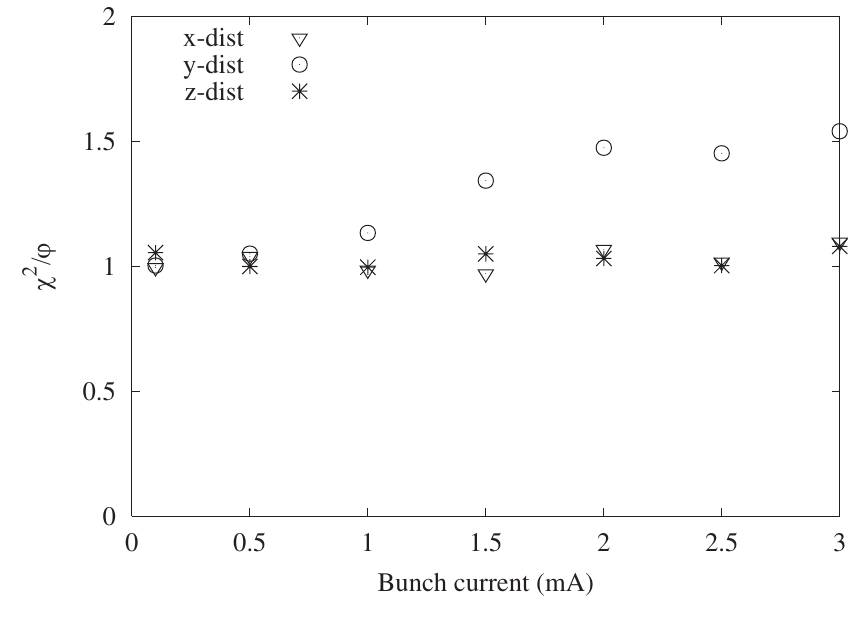
FIG. 10. (cid:7) 2 per degree of freedom for fitted